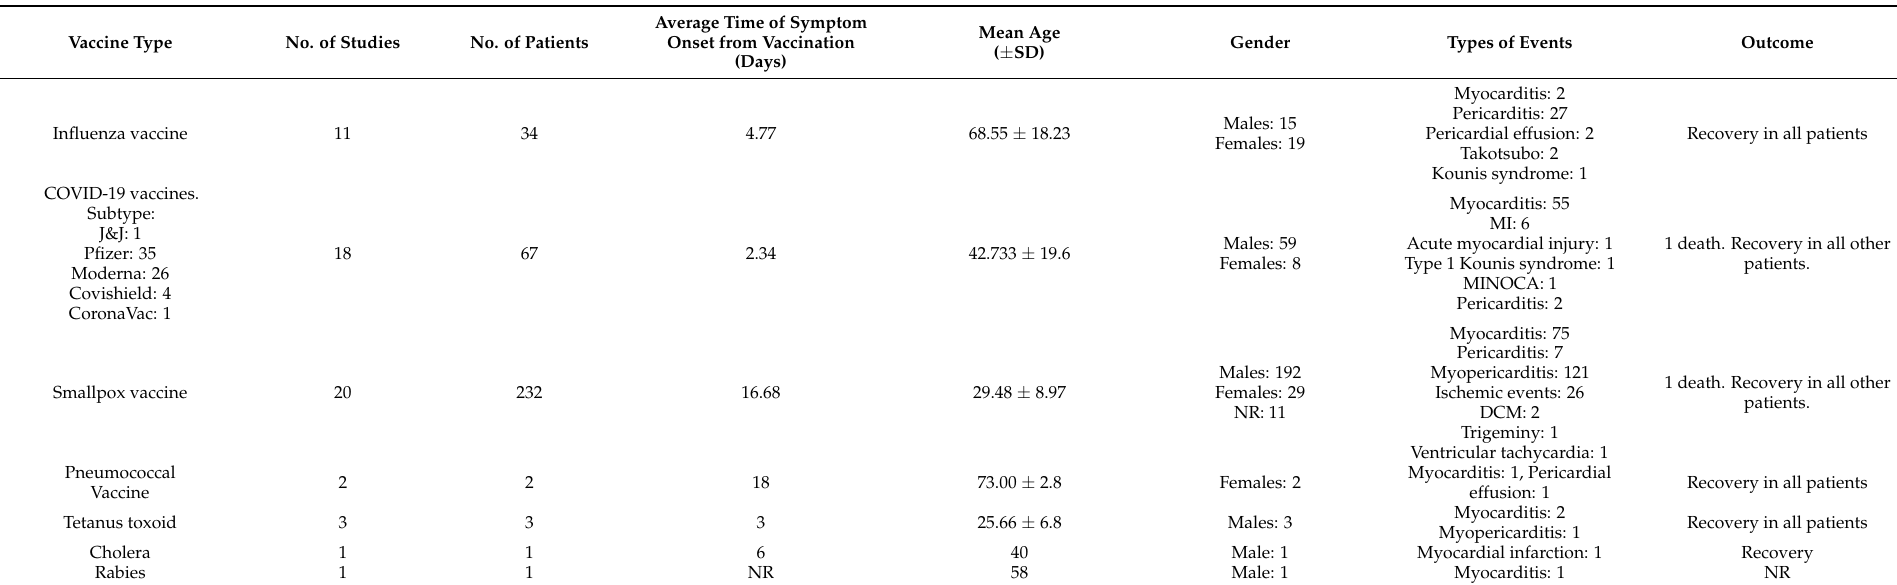
Table 1. Summary of Vaccine Related Cardiac Adverse